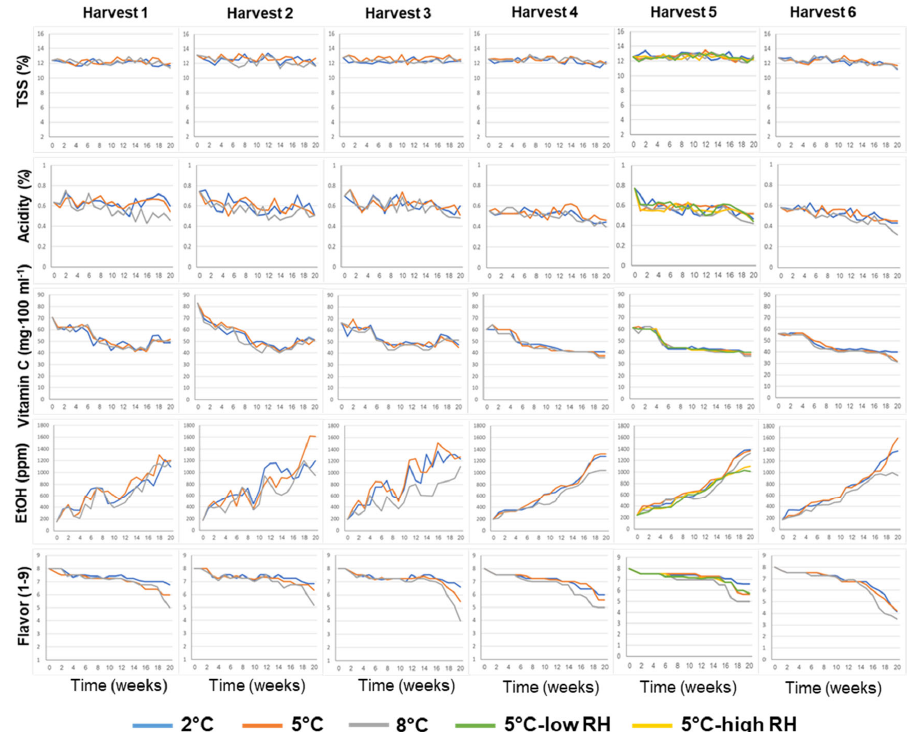
Figure 3. Effects of various pre-harvest and postharvest features on the biochemical composition and flavor of ‘Rustenburg’ navel oranges harvested from six different orchards. The harvest times and yields of the different orchards are presented in Table 1. The postharvest features included storage temperature (2, 5 or 8 °C) and storage RH (70, 90 or 95%). Fruit quality was evaluated every week after one additional week of storage under shelf conditions (20 °C) for a period of 20 weeks. Overall, fruit ‐ acceptance scores remained relatively high (acceptance score ≥ 4, on a scale of 1 to 5) for 14–19 weeks, depending on the various pre ‐ harvest and postharvest features (Figure 4). It is worth noting that the fruits stored at 5 °C maintained high ac ‐ ceptance scores for longer periods when compared to the fruits stored at a lower temper ‐ ature of 2°C or a higher temperature of 8 °C.